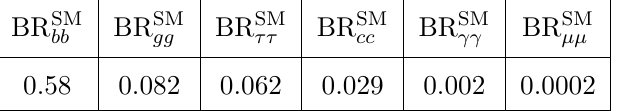
Table 6 . SM Branching Ratios for the Higgs boson decaying into ψψ , taking m h = 125 . 10 GeV